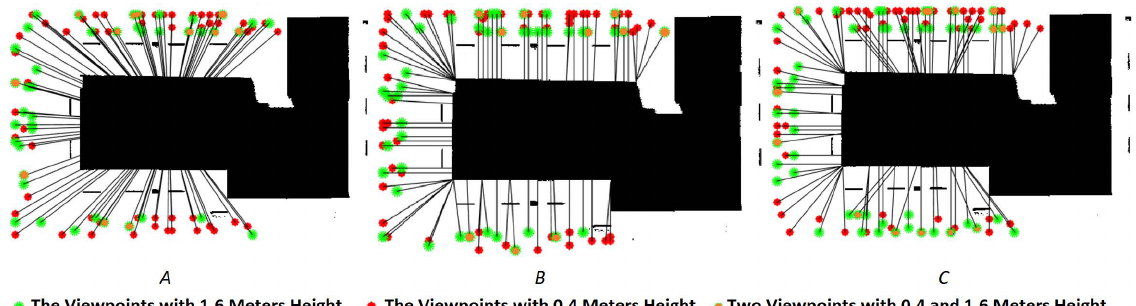
Figure 12. The final vantage viewpoints selected from the candidate viewpoints for the façade pointing ( A ), centre pointing ( B ), and hybrid ( C ) imaging networks.